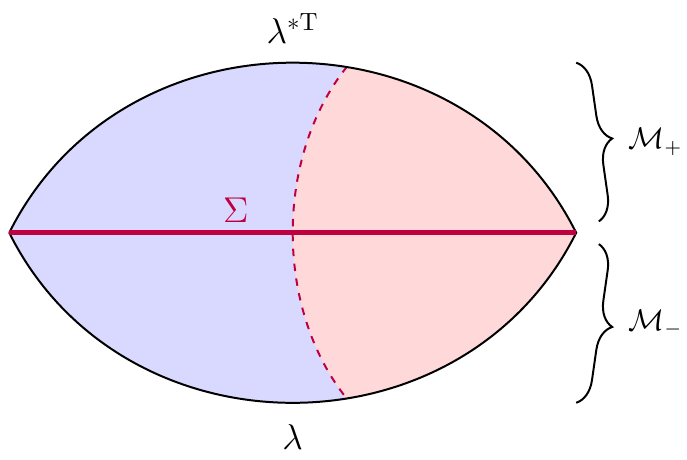
Figure 3. When λ 1 = λ 2 , all the fields are invariant under time reflection and complex conjugation. This symmetry fixes a surface Σ which divides M into a past piece M − and a future piece M +